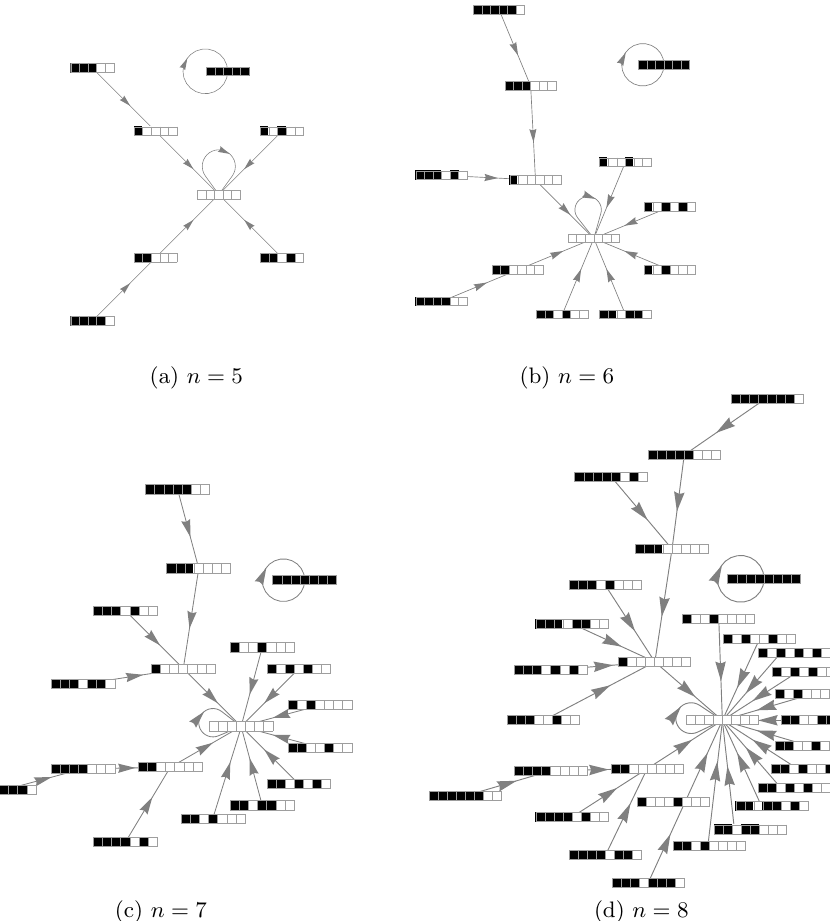
Figure 4: The state graph for the ESPD on a cycle of order n a + b > 2 . The rectangular arrays of cells in the figure should be interpreted as wrapping arrays in the sense that the right-most cells wrap around so as to be adjacent to the left-most cells. A solid cell denotes a player who cooperates while an open cell denotes a player who